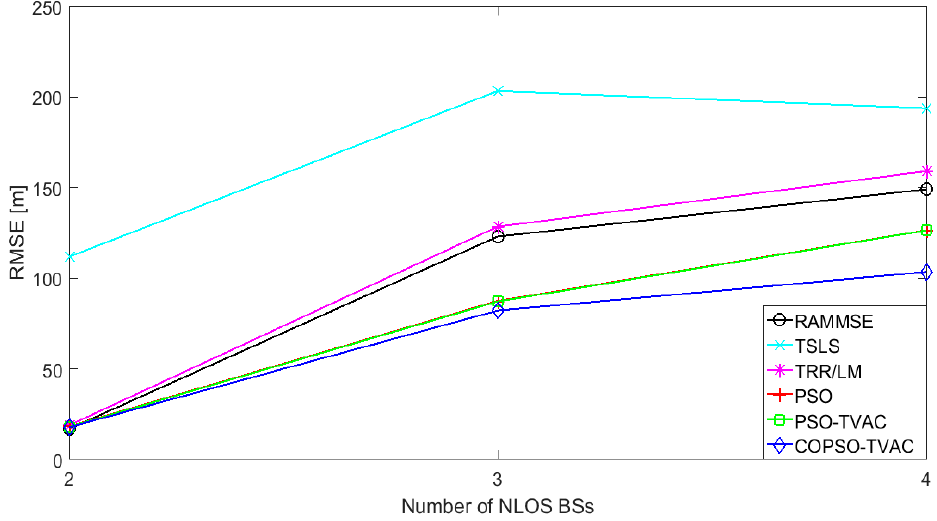
Figure 3. RMSE [m] in the function of the number of the NLOS BSs: the suburban environment.